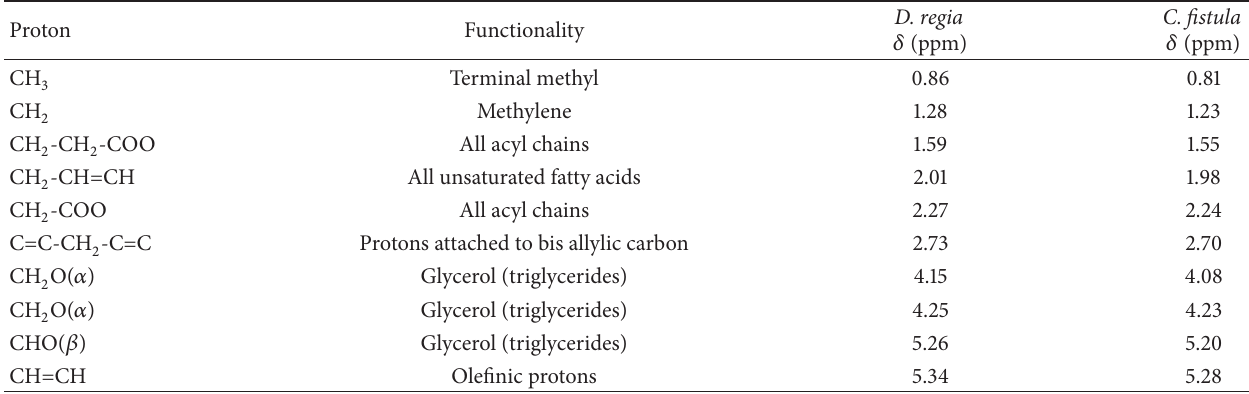
Table 4: 1 H Nuclear magnetic resonance spectroscopy data of seed lipid extracts.